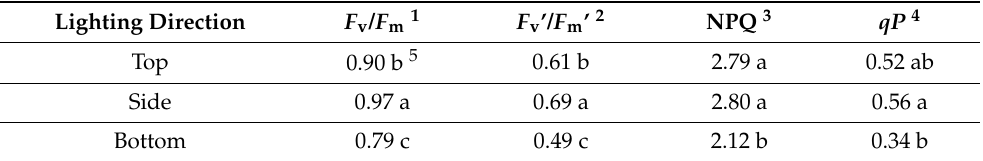
Table 3. Influence of the lighting direction on the chlorophyll fluorescence characteristics of strawberries grown for 45 days.